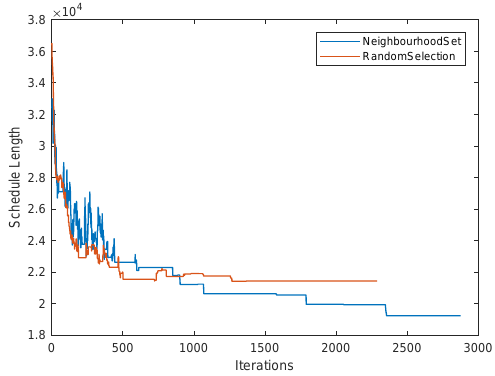
Figure 7. Iterative